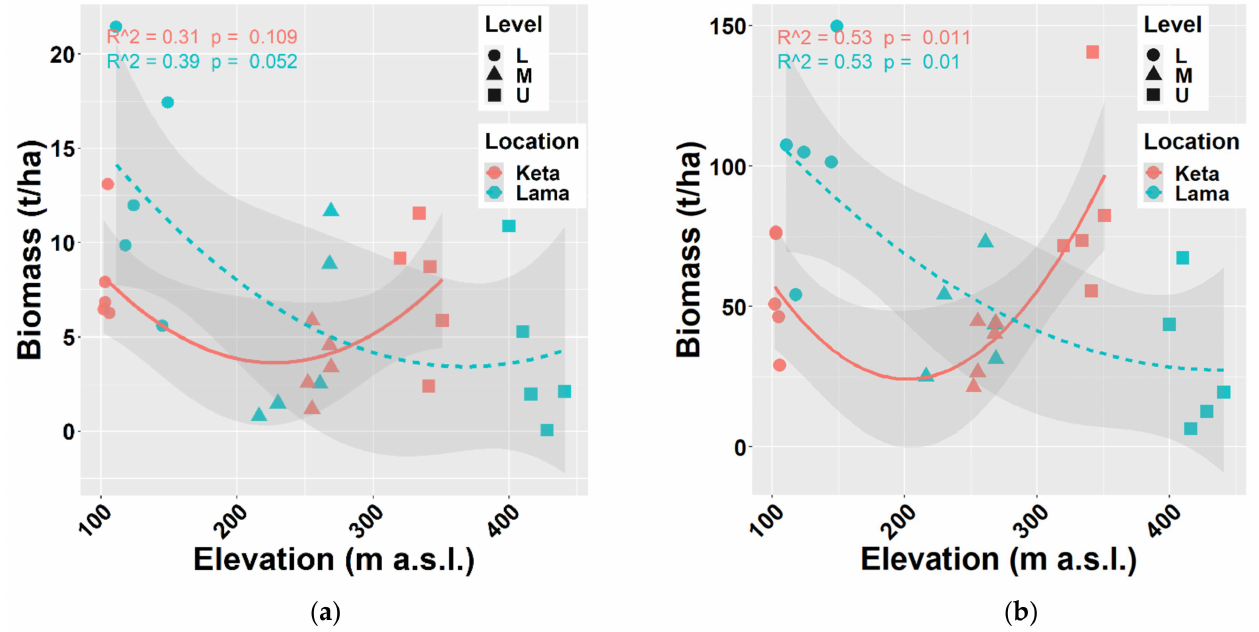
Figure 5. Relationships between elevation and biomass of deadwood ( a ) and total biomass (living and deadwood together) ( b ) at two locations. Points represent biomass values at individual sample plots. Lines represent fitted non-linear models, and grey areas show 95% confidence intervals around the fitted models. Level: L—lower elevational zone, M—middle elevational zone, U—upper elevational